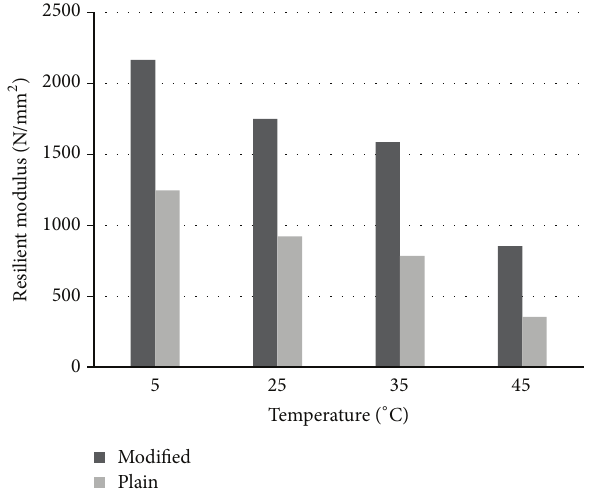
Figure 2: Resilient modulus values for the mix plain and modified aggregate (plastic coated).